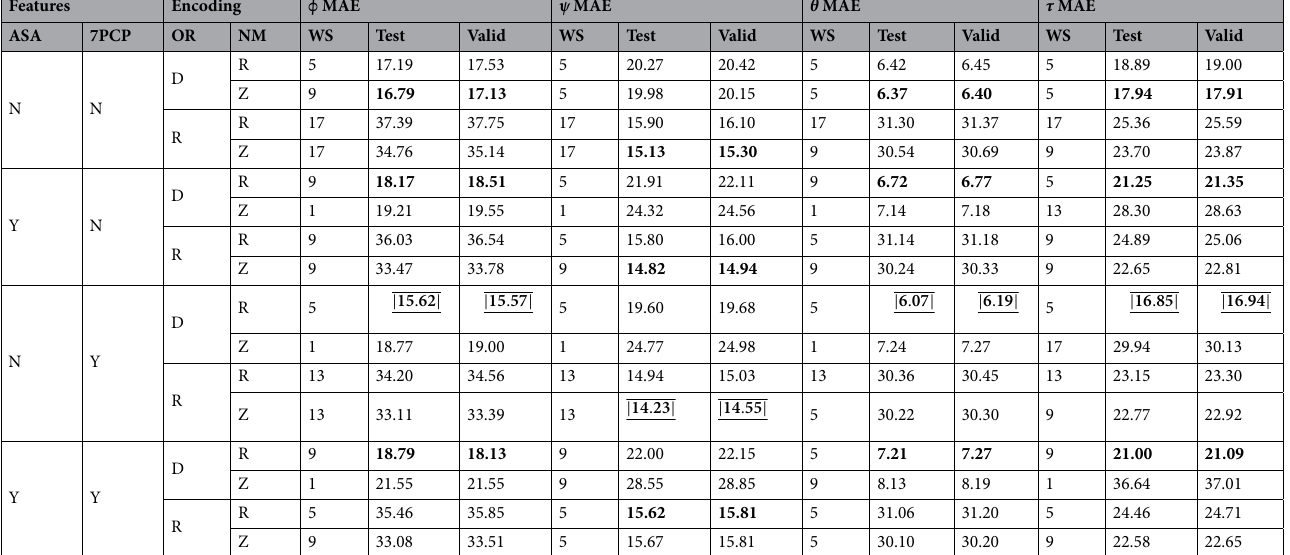
Table 2. Performance of SAP settings on 1206 testing proteins. In the table, column ASA denotes whether accessible surface area is used (Yes/No), column 7PCP denotes whether 7 physicochemical properties are used (Yes/No), column OR denotes output representation is in direct angles (D) or trigonometric ratios (R), column NM denotes normalisation method for input feature encoding is [0,1] range based (R) or Z-score based (Z), WS denotes the best size of the sliding window. Note that the emboldened cells denote the best performance for each combination of ASA and 7PCP while the boxed plus emboldened cells in each respective column denote the best performance among all SAP